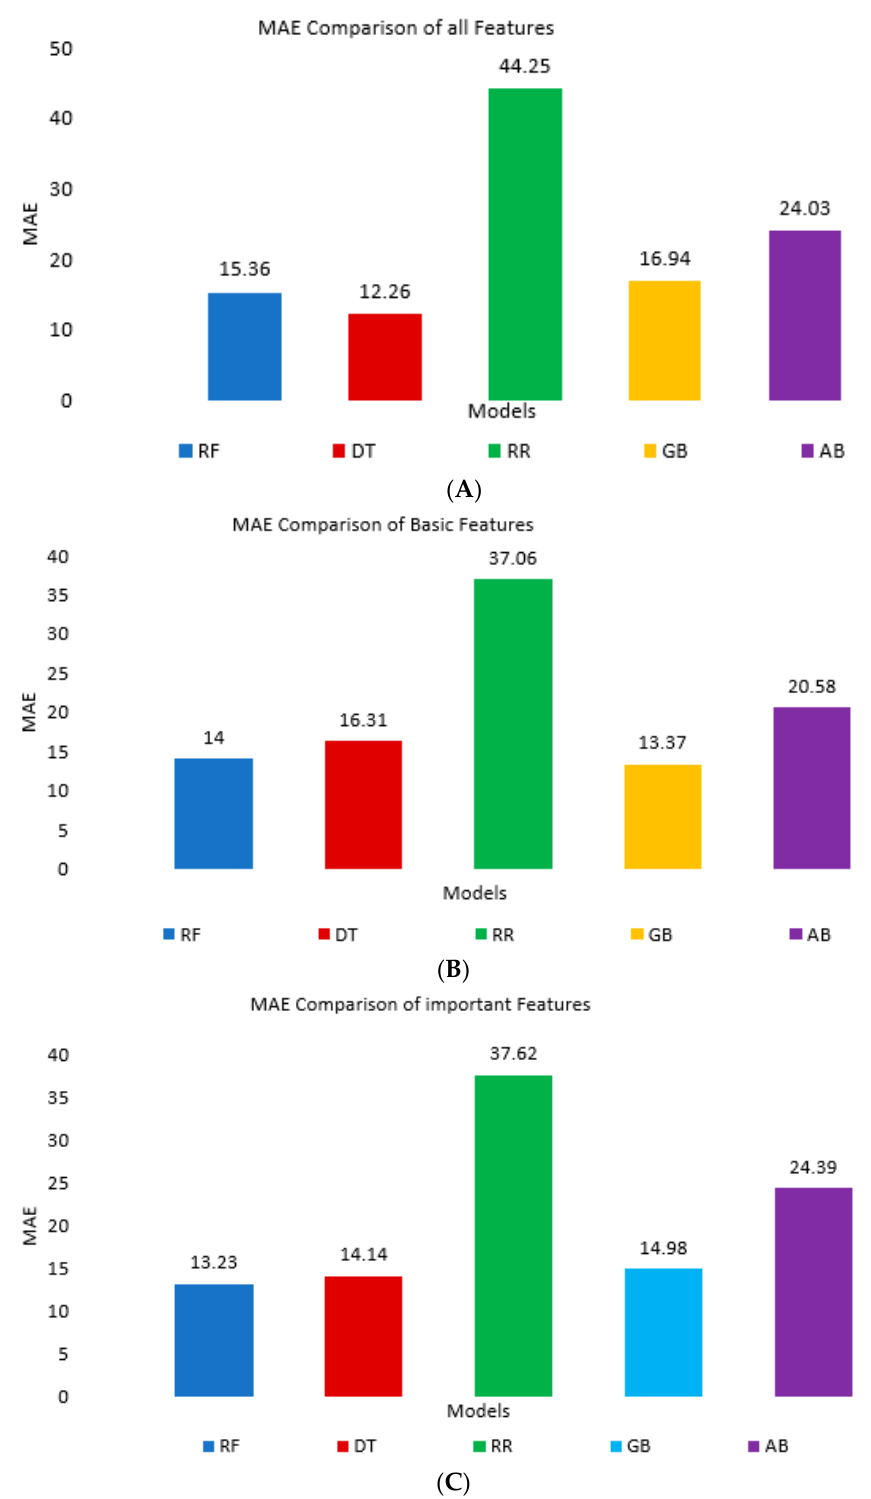
Figure 13. MAE Comparisons of ( A ) full, ( B ) basic, and ( C ) important sparse matrix features.